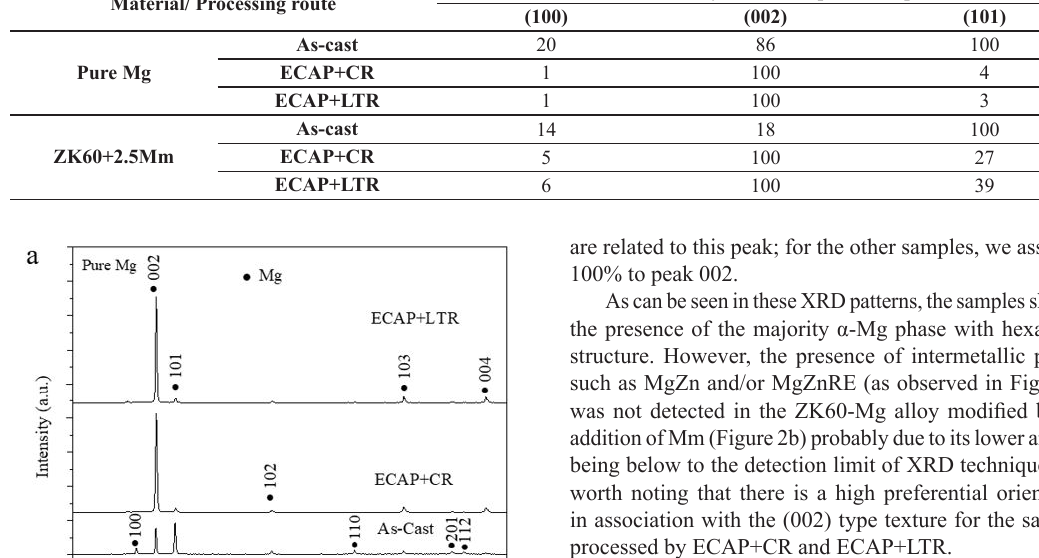
Figure 1. Optical microscopy images obtained with polarized light for (a) pure Mg and (b) ZK60 + 2.5Mm alloy in the as-cast state. Table 1. Summary of relative intensity of the planes related to the α-Mg peaks. Material/ Processing